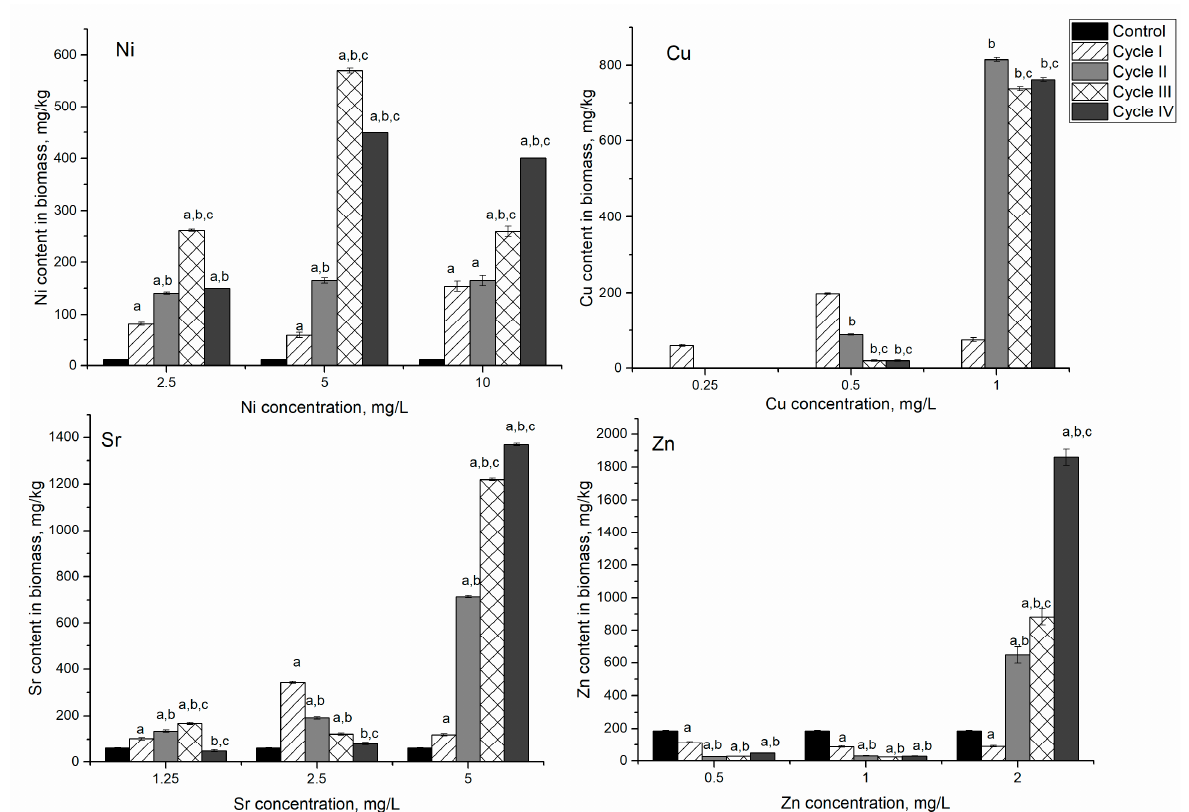
Figure 7. Accumulation of metal ions in spirulina biomass during repeated cultivation in the me- dium containing metal ions at concentrations: nickel 2.5–10 mg/L, copper 0.5–1 mg/L, strontium— 1–5 mg/L, and Zn—0.5–2 mg/L. a: p < 0.001 for the difference between experimental and control samples; b: p < 0.001 for the difference from the first cycle; c: p < 0.001 for the difference from the second cycle.